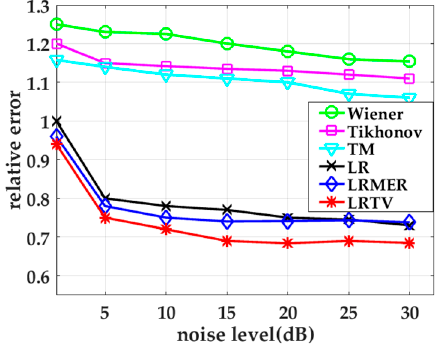
Figure 12. RE curve comparison under different noise levels.